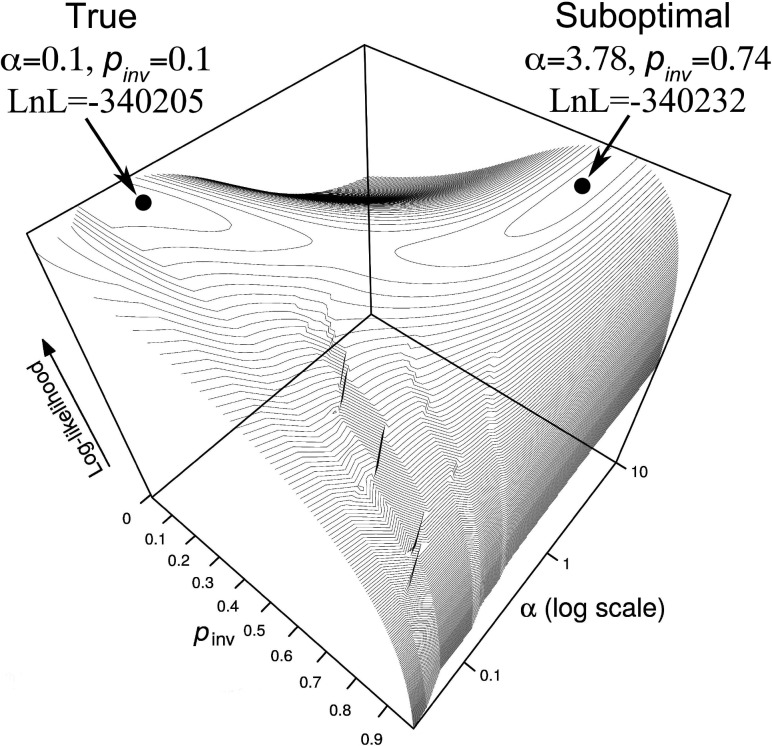
The likelihood surface for one simulated alignment as a function of \documentclass[12pt]{minimal}
\usepackage{amsmath}
\usepackage{wasysym} 
\usepackage{amsfonts} 
\usepackage{amssymb} 
\usepackage{amsbsy}
\usepackage{upgreek}
\usepackage{mathrsfs}
\setlength{\oddsidemargin}{-69pt}
\begin{document}
}{}$\alpha $\end{document} and \documentclass[12pt]{minimal}
\usepackage{amsmath}
\usepackage{wasysym} 
\usepackage{amsfonts} 
\usepackage{amssymb} 
\usepackage{amsbsy}
\usepackage{upgreek}
\usepackage{mathrsfs}
\setlength{\oddsidemargin}{-69pt}
\begin{document}
}{}$p_{\rm inv}$\end{document}.